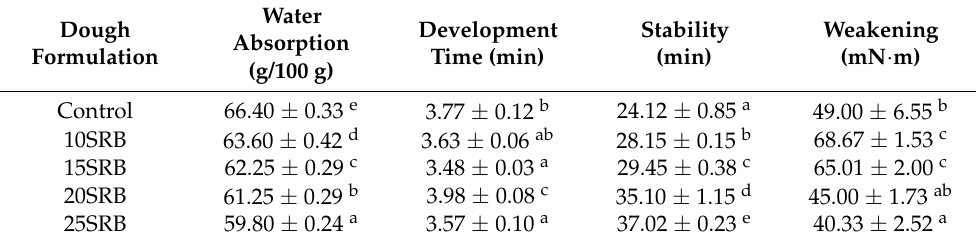
Table 2. Mixing properties of control and experimental doughs formulated with different levels of SRB substitution. Dough Formulation